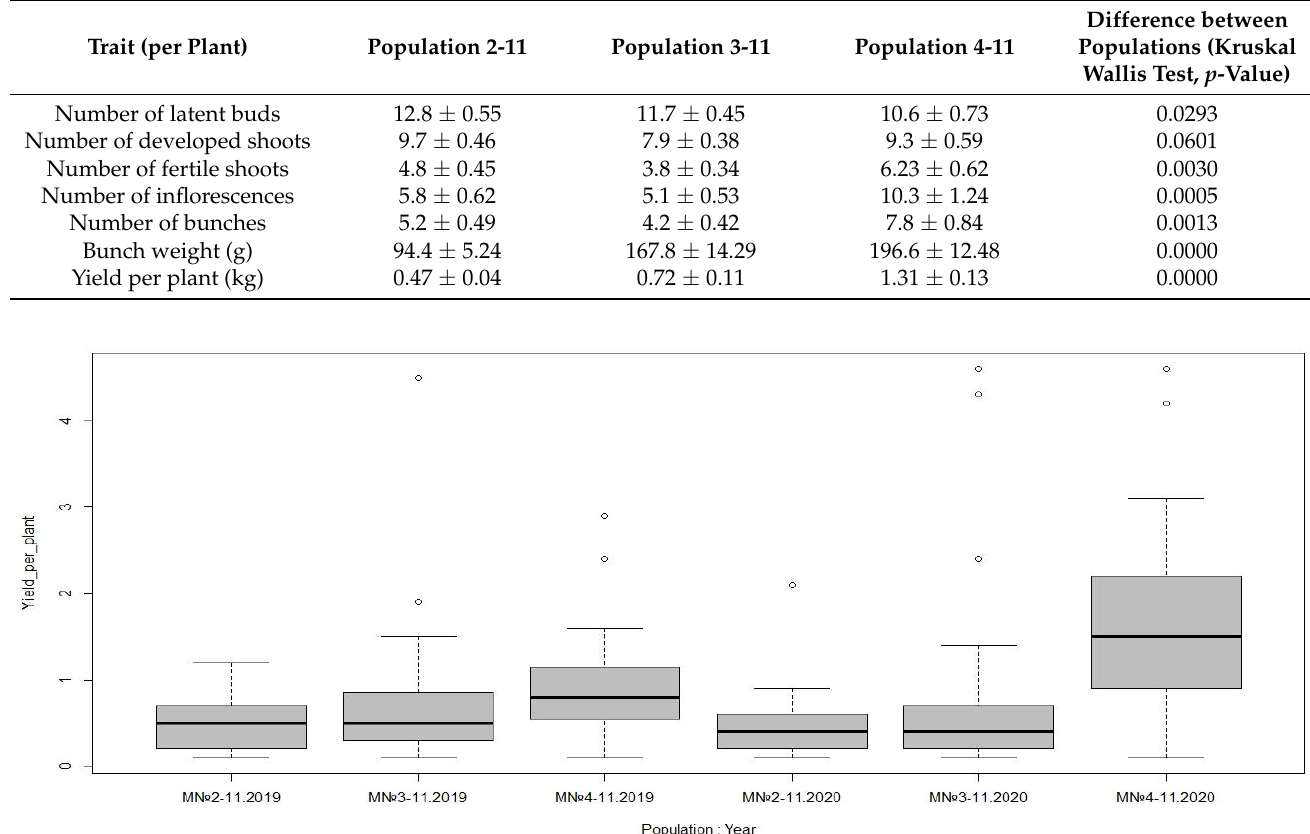
Table 2. Variation of the yield-contributing agrobiological traits between flowering plants of the hybrid populations ana- lyzed. Field evaluation data were averaged for 2019 and 2020.